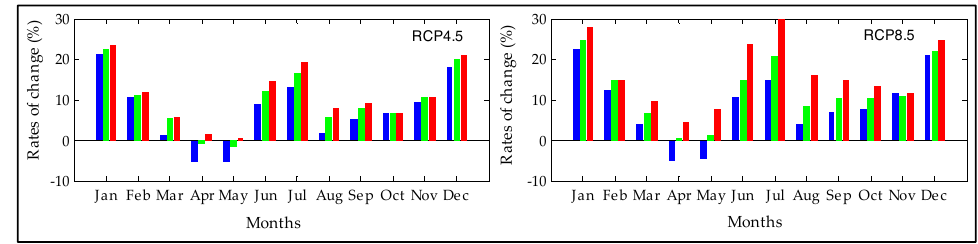
Figure 6. Rates of change of monthly PET per projected period (blue: P1; green: P2 and red: P3).